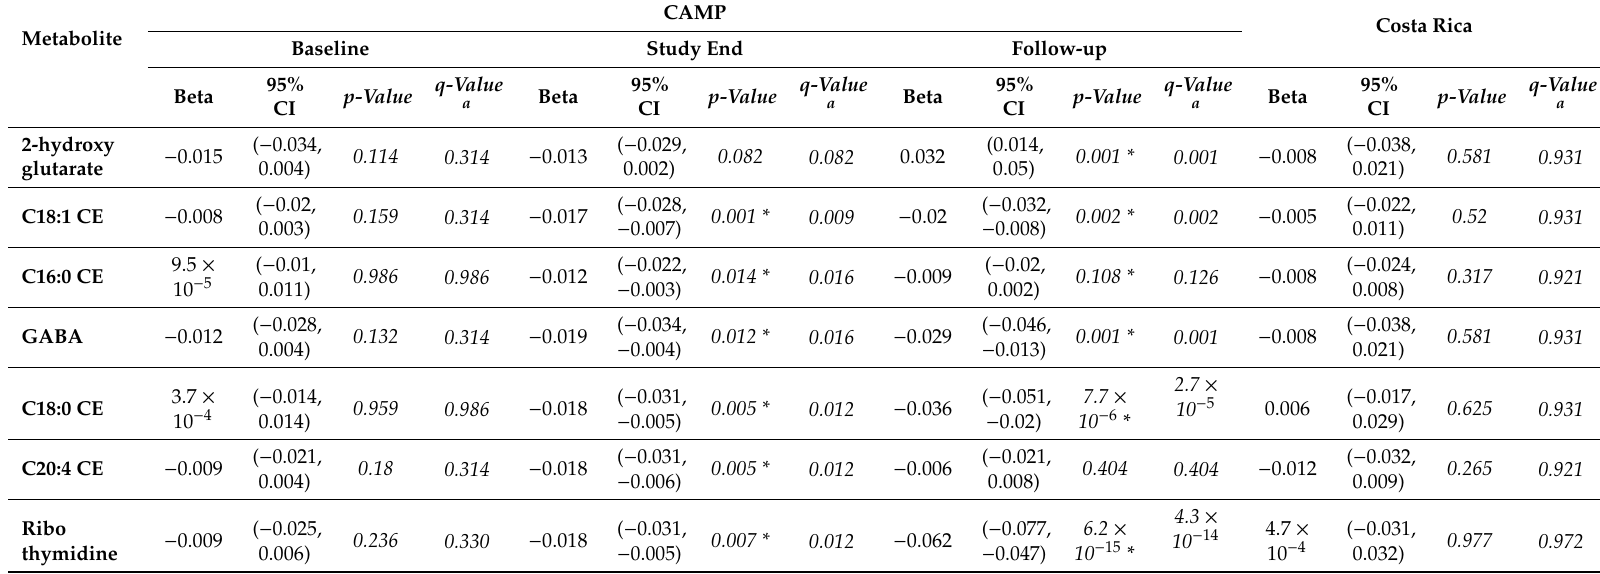
Table 4. Relationship between metabolite levels and age at sample collection in CAMP and